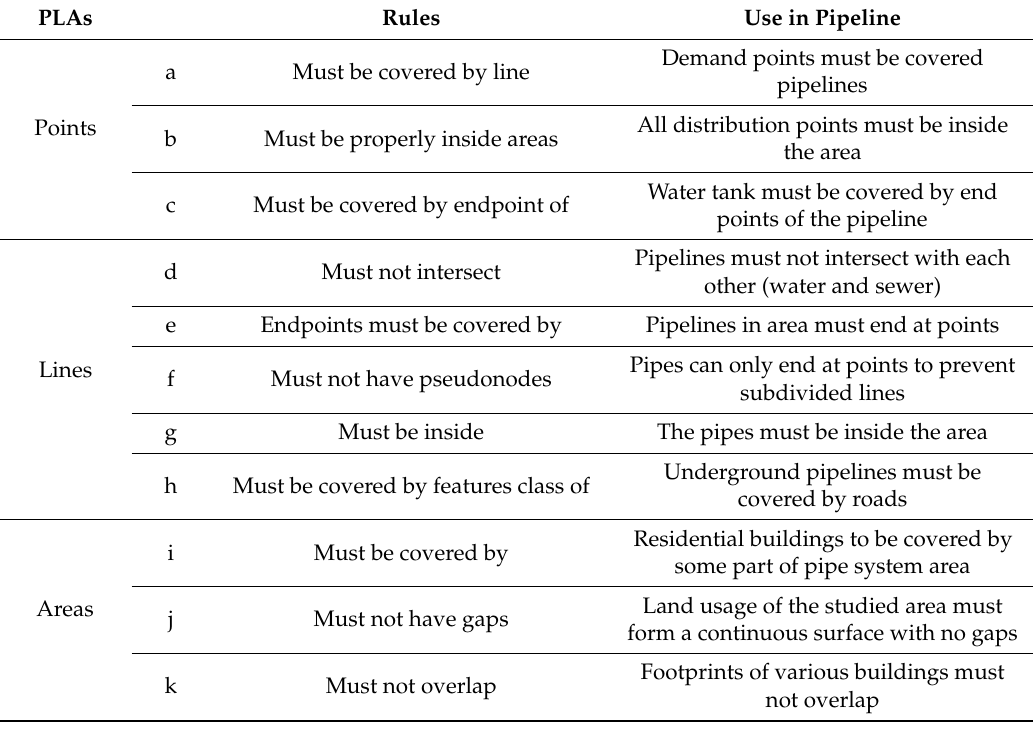
Table 1. GIS-based topological rules used in this